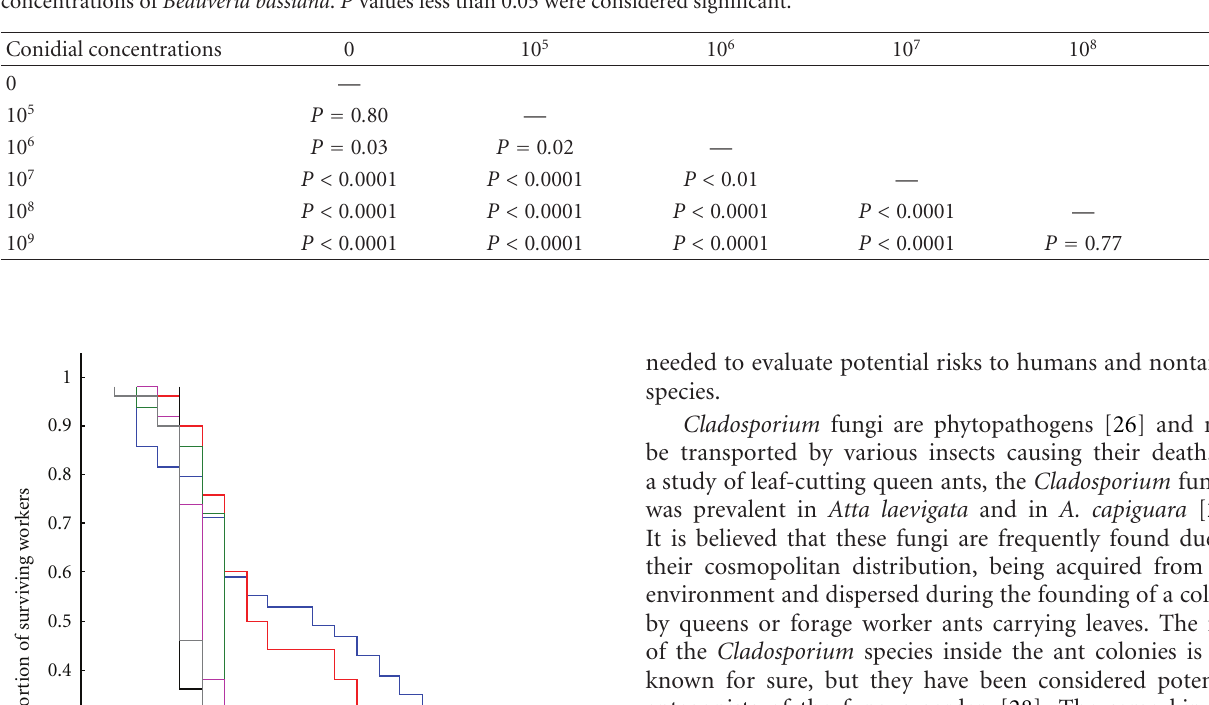
Table 3: P values of Log-rank test to compare two Kaplan-Meier survival curves for Atta bisphaerica workers treated with di ff erent conidial concentrations of Beauveria bassiana . P values less than 0.05 were considered significant.